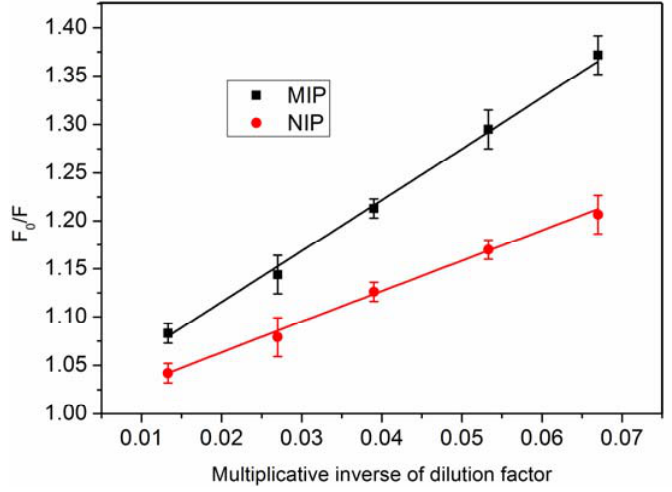
/F and multiplicative inverse of dilution 0